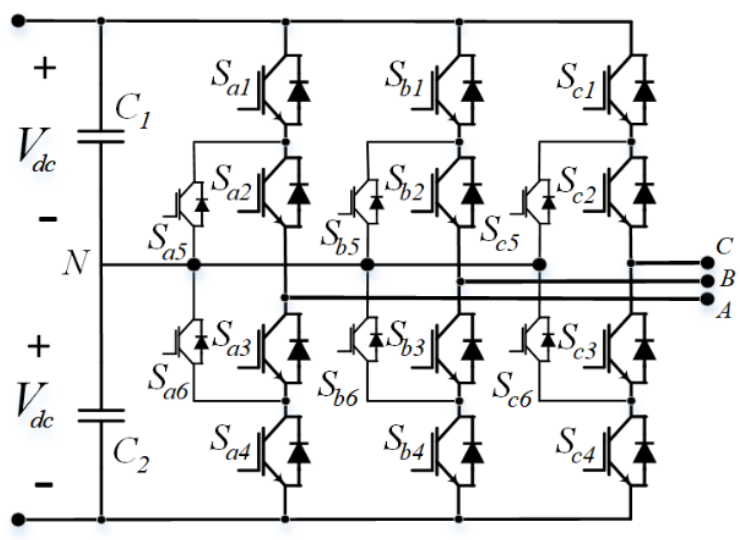
Figure 4. Three-level active neutral point clamped (ANPC) inverter topology.